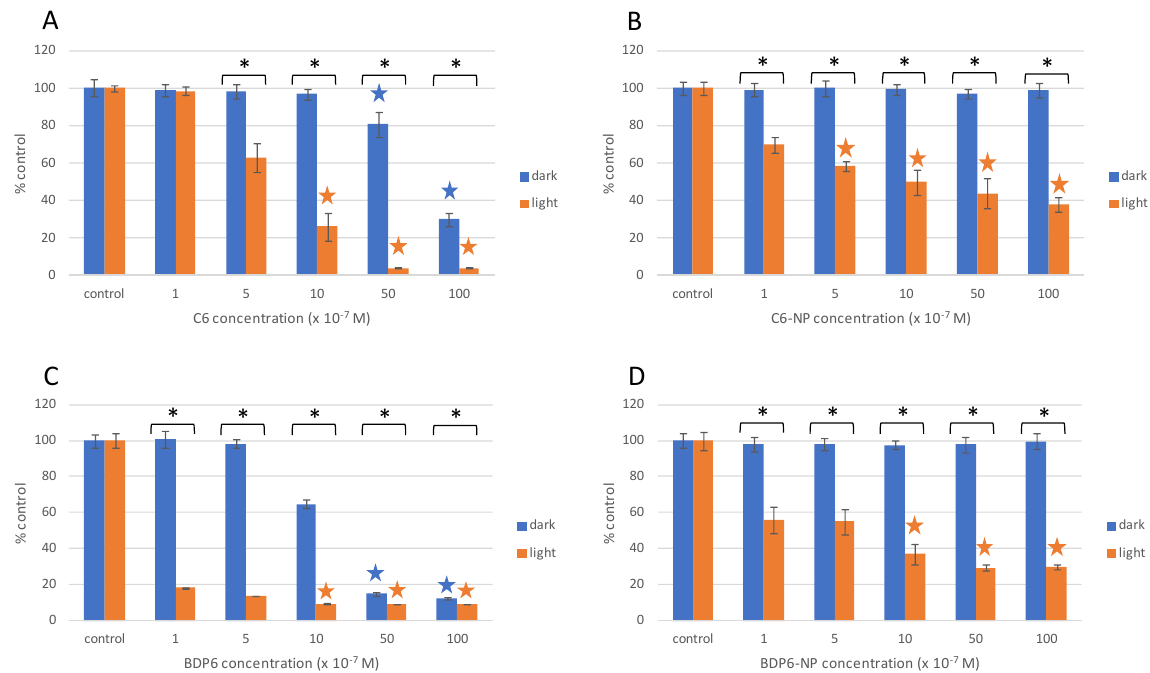
Figure 8. Cell viability (MTT assay) of HeLa cells exposed to PSs in solution C6 ( A ) and BDP6 ( C ) and to their respective the nanosystems C6-NP ( B ), and BDP6-NP ( D ) under dark conditions (blue bars) and after red irradiation at 15 J/cm 2 (orange bars). Stars indicate significant differences with respect to controls. Asterisks indicate significant differences between dark and light conditions at the same concentrations tested.